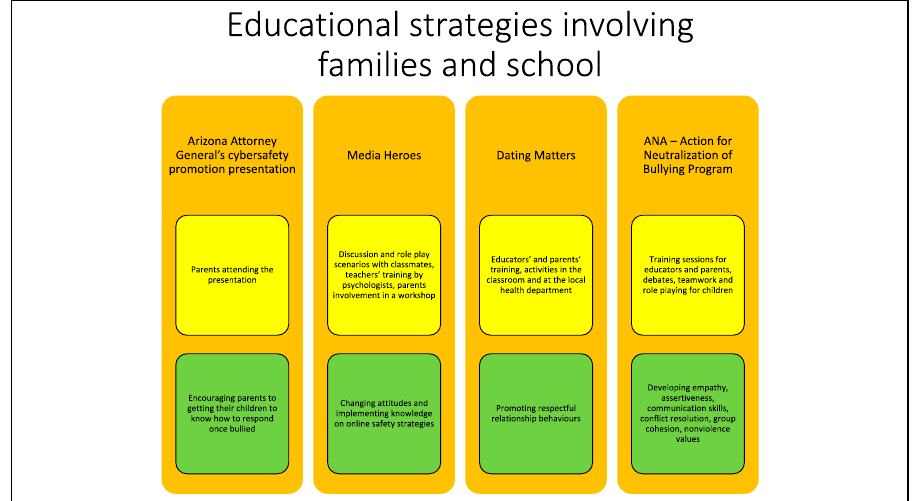
Figure 3. This figure summarizes descriptions and objectives of the educational strategies involving families and school that will be presented below. The name of the strategy is reported in orange boxes. Yellow boxes contain different strategies’ descriptions, while objectives are stated in the green boxes.